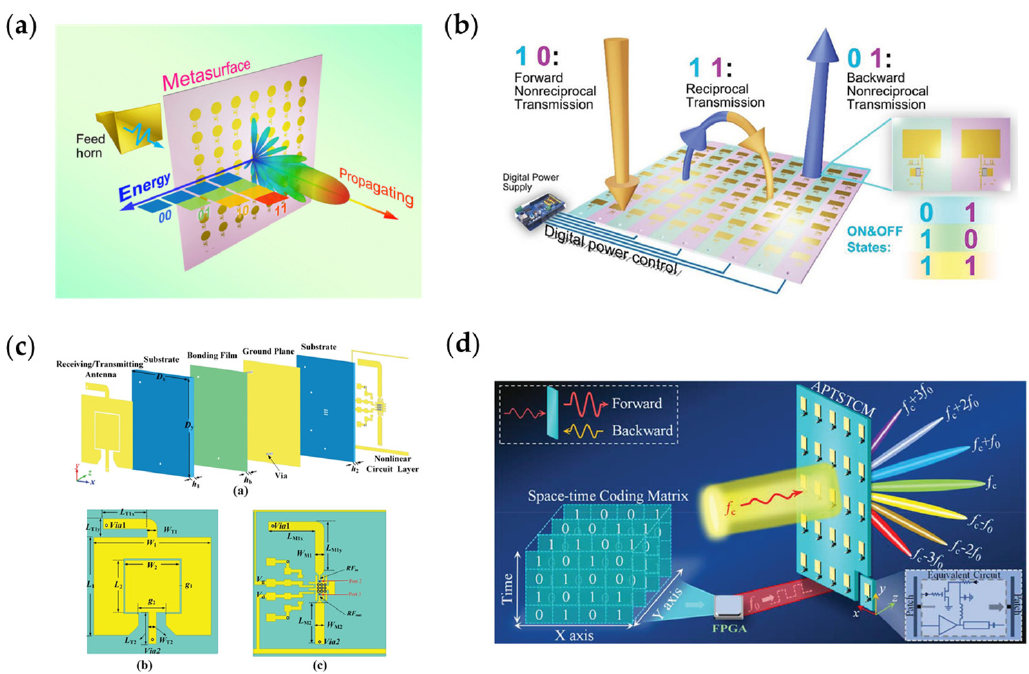
Figure 12. ( a ) Multi-layer metasurface loaded with active RF amplifiers realizing tunable amplitude modulation. Reprinted Figure 1 with permission from [247], copyright 2023 by the American Physical Society; ( b ) Metasurface loaded with amplifiers realizing nonreciprocal transmission. Reprinted with permission from [248], copyright© 2000–2023 by John Wiley and Sons, Inc. or related companies. All rights reserved; ( c ) Metasurface frequency multiplier based on the nonlinearity of amplifi- ers; ( d ) Space–time metasurface based on amplitude modulation.